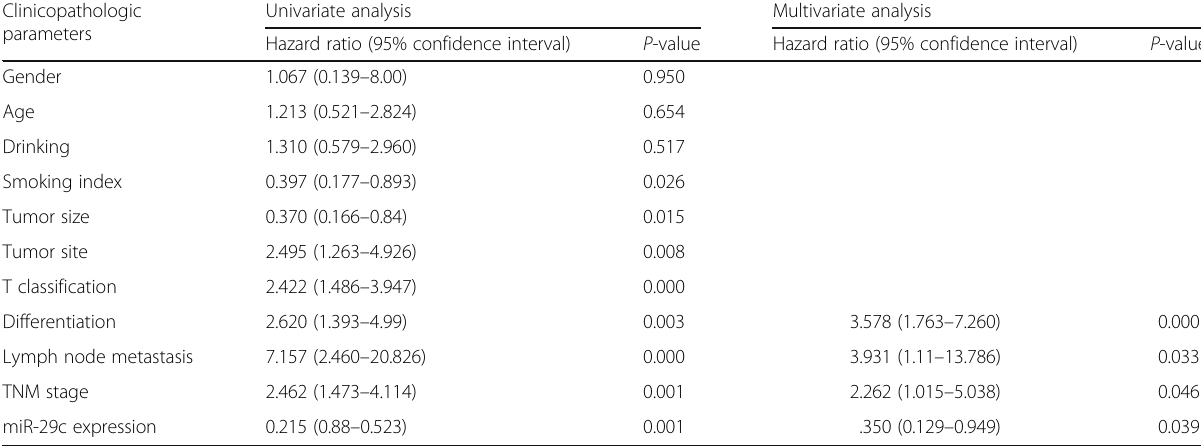
Table 2 Univariate and multivariate Cox hazard regression analysis for patient prognosis in LSCC Clinicopathologic